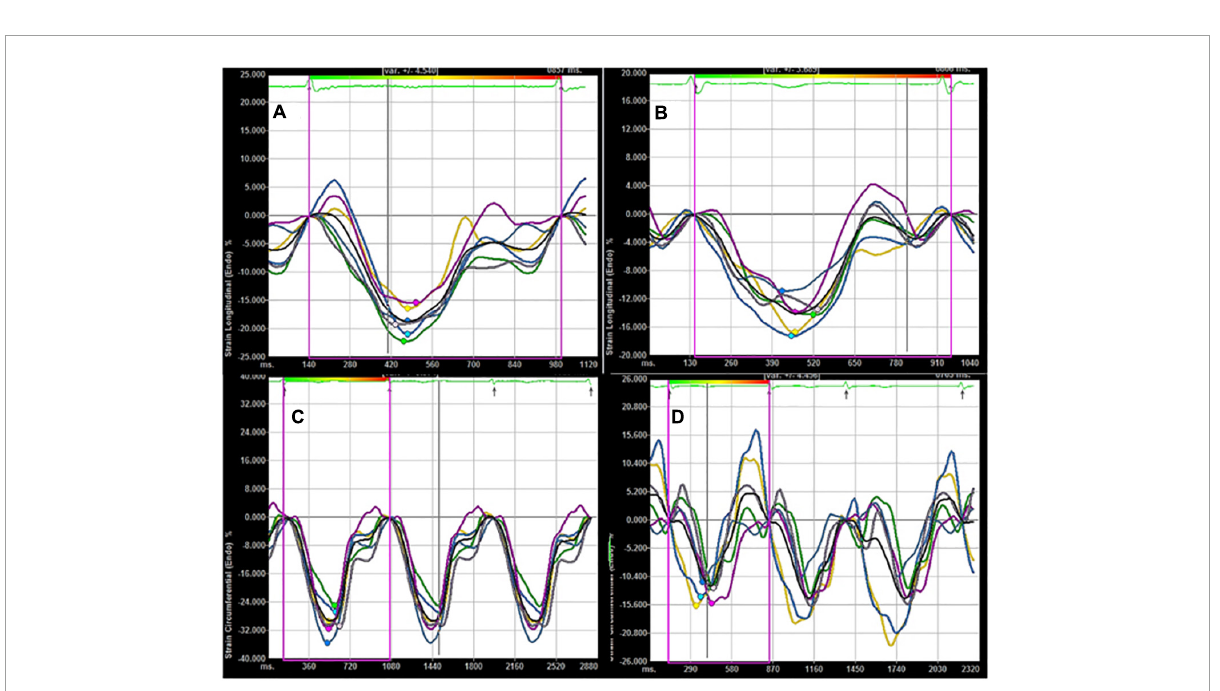
FIGURE2 (A) Longitudinal LV strain in a control subject; (B) longitudinal LV strain in a patient with AF; (C) circumferential LV strain in a control subject; (D) circumferential LV strain in a patient with AF. Compared with control subject, lower absolute values of longitudinal and circumferential LV strain were found in a patient with